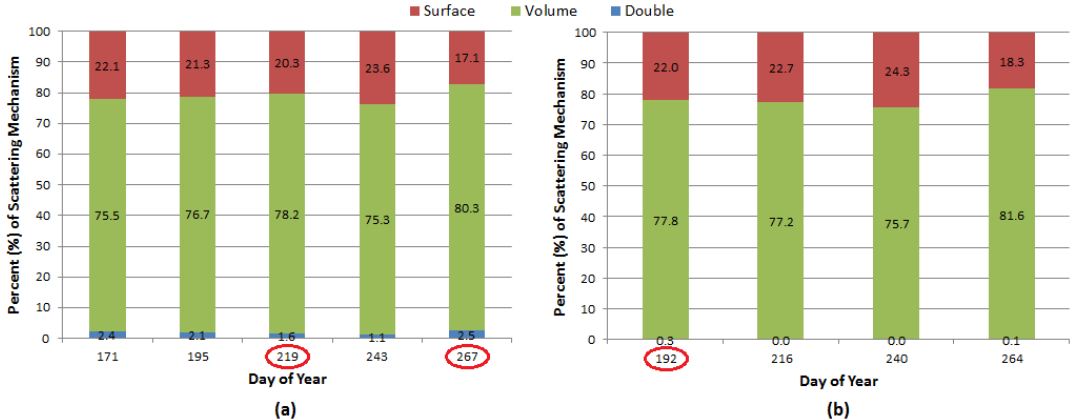
Figure 8. Forest Freeman-Durden decomposition for ( a ) 41° and ( b ) 26° incidence angles based on RADARSAT-2 fine-quad beam modes. Note that circled days coincide with polarization response plot and Cloude-Pottier decomposition dates.